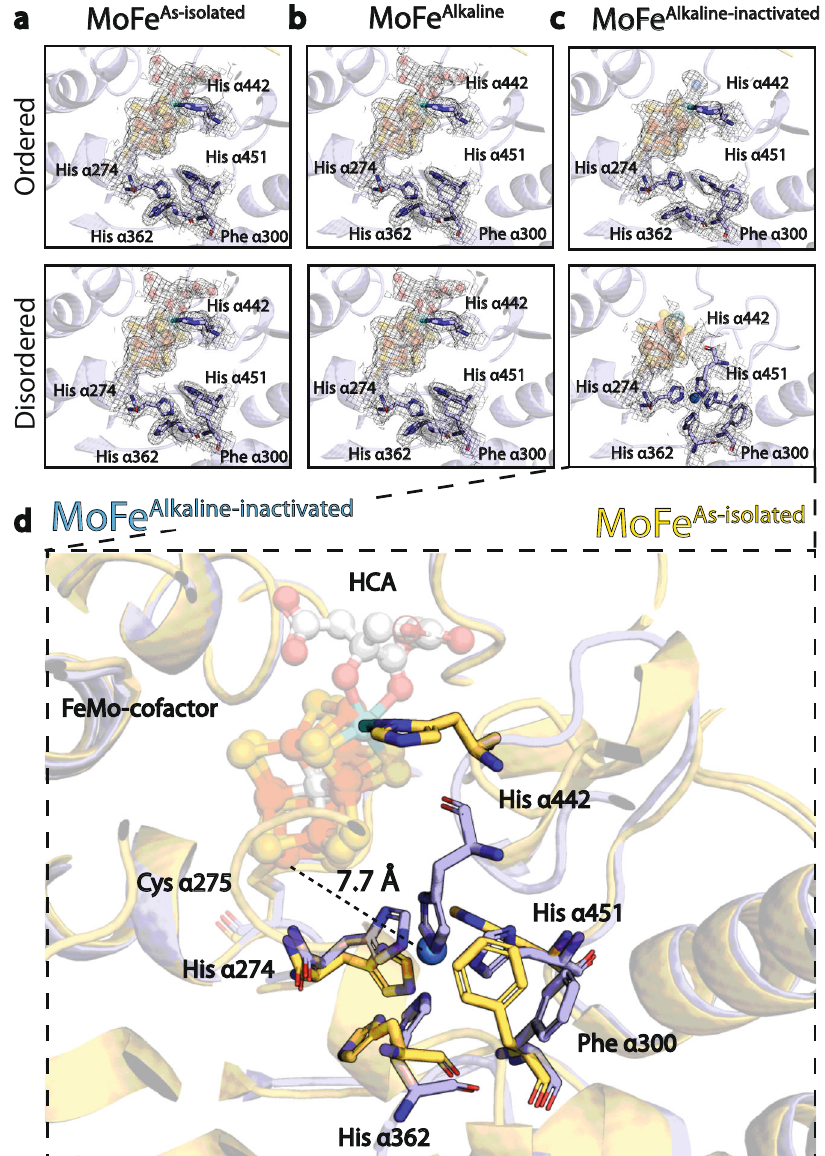
Fig. 3 | His-coordination site formation within the high pH turnover- inactivated state. a His α 274, His α 362, and His α 451 within MoFe As-isolated puri fi ed from A. vinelandii . The upper panel displays the His-coordination site in the more ordered dimer, while the lower panel displays the more disordered dimer. b His α 274, His α 362, and His α 451 in MoFe Alkaline from an acetylene reduction reaction performedatpH9.5withoutATPisolatedviaS.E.C.conductedatpH7.8.Theupper paneldisplaystheHis-coordinationsiteinthemoreordereddimer,whilethelower panel displays the more disordered dimer. c His α 274, His α 362, and His α 451 in